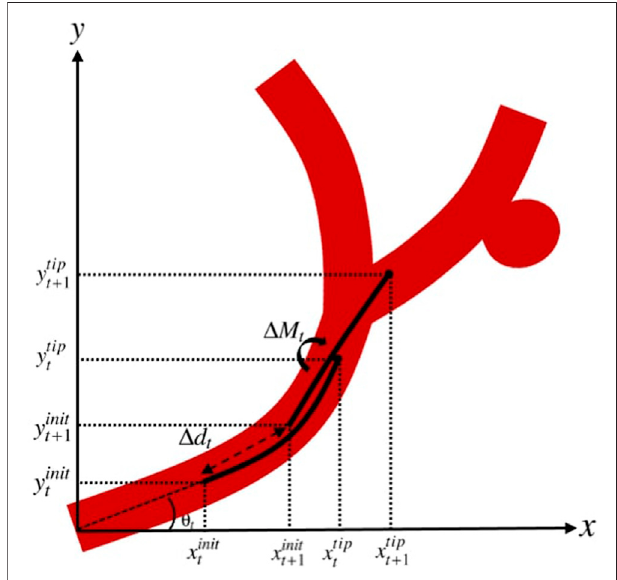
FIGURE 5 | Actions applied to the catheter to guide it from the state at step t to t +1.